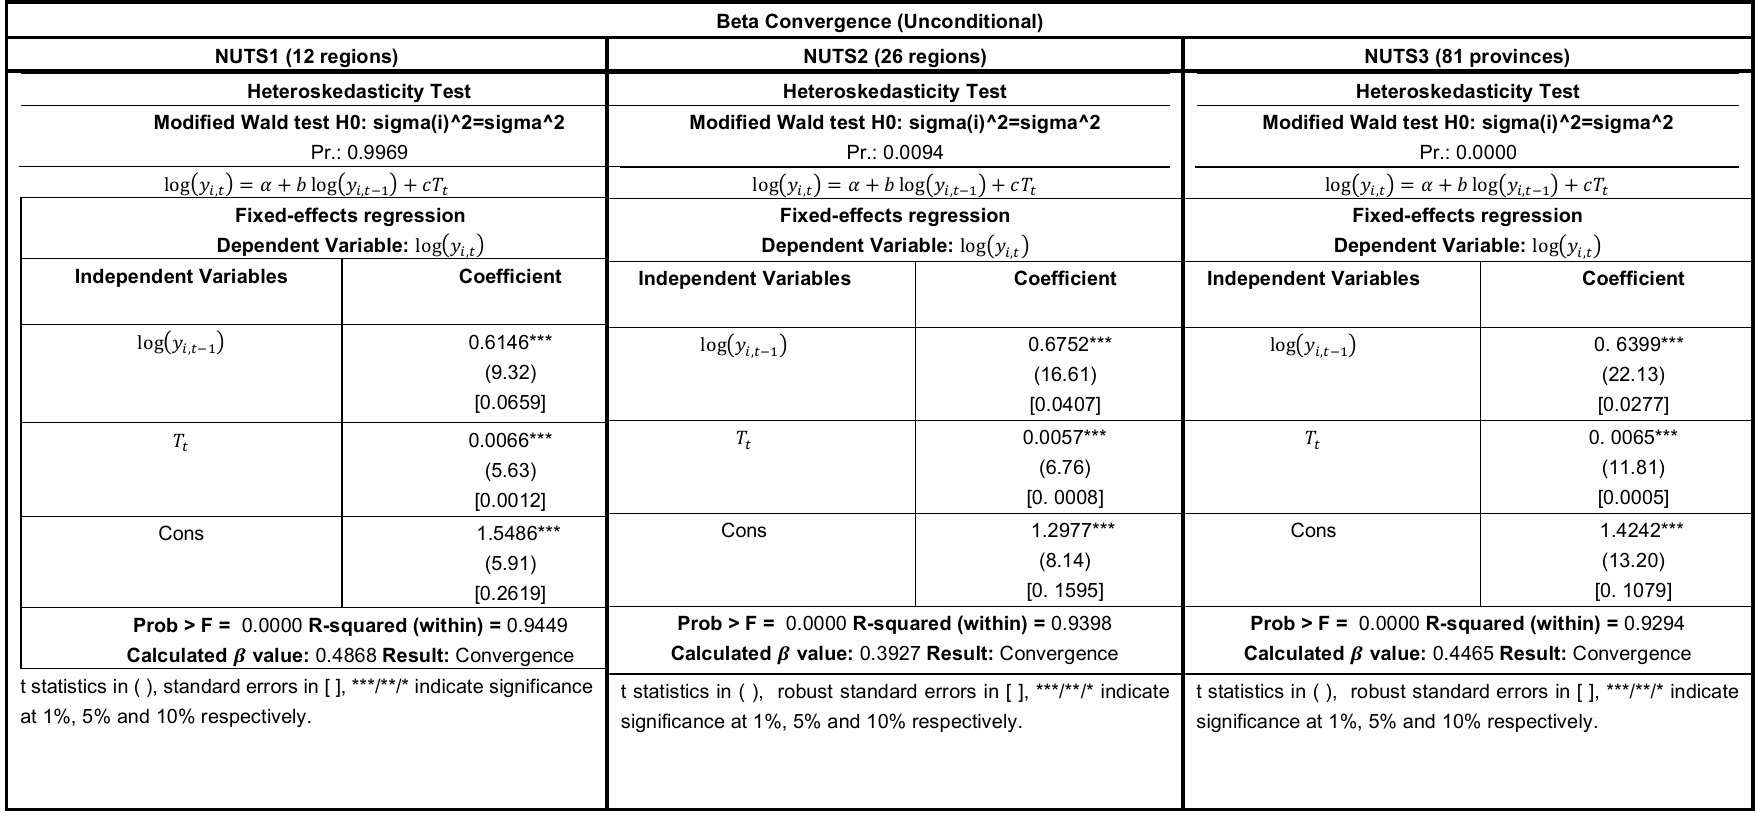
Table 1: Beta Convergence